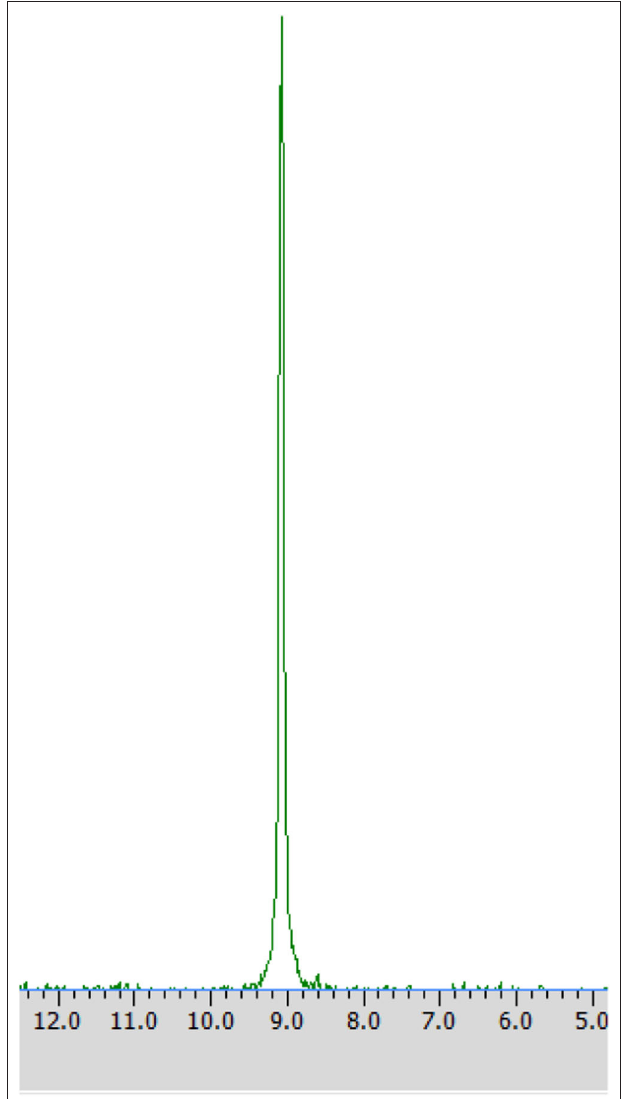
FIGURE 5 | 31 P NMR spectra of post-bioconversion mixture recorded with the addition of CSA, after biotransformation of racemic